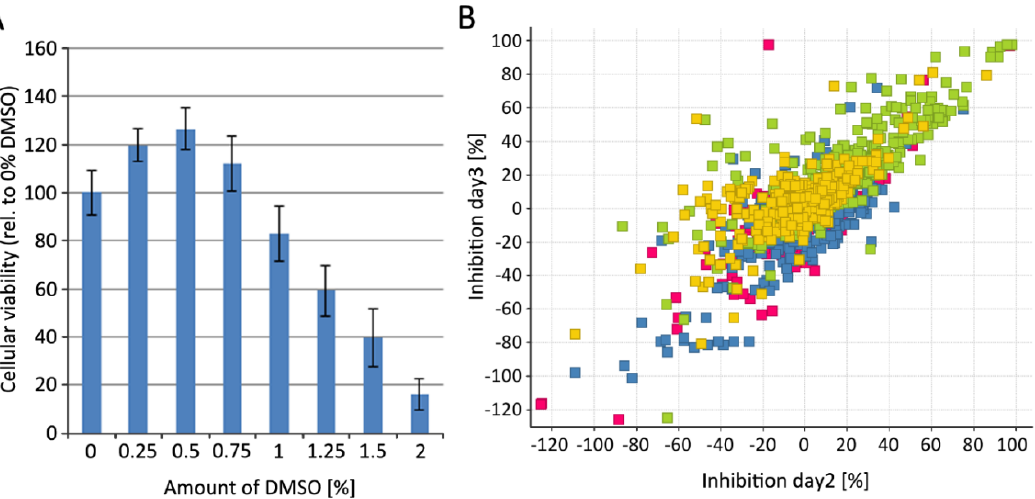
Figure 3. PM1-mCat1 cell-based assay development. ( A ) Viability of the PM1-mCat1 cell line in relation to DMSO concentration. ( B ) Marker library consisting of 1320 compounds was screened at 5 µM. PM1-mCat1 cells incubated for two days with compounds and viral particles are plotted against a 3-day incubation. Color coding is in accordance with plate numbers. First plate is shown in red, second in blue, third in green and the fourth plate is shown in yellow.